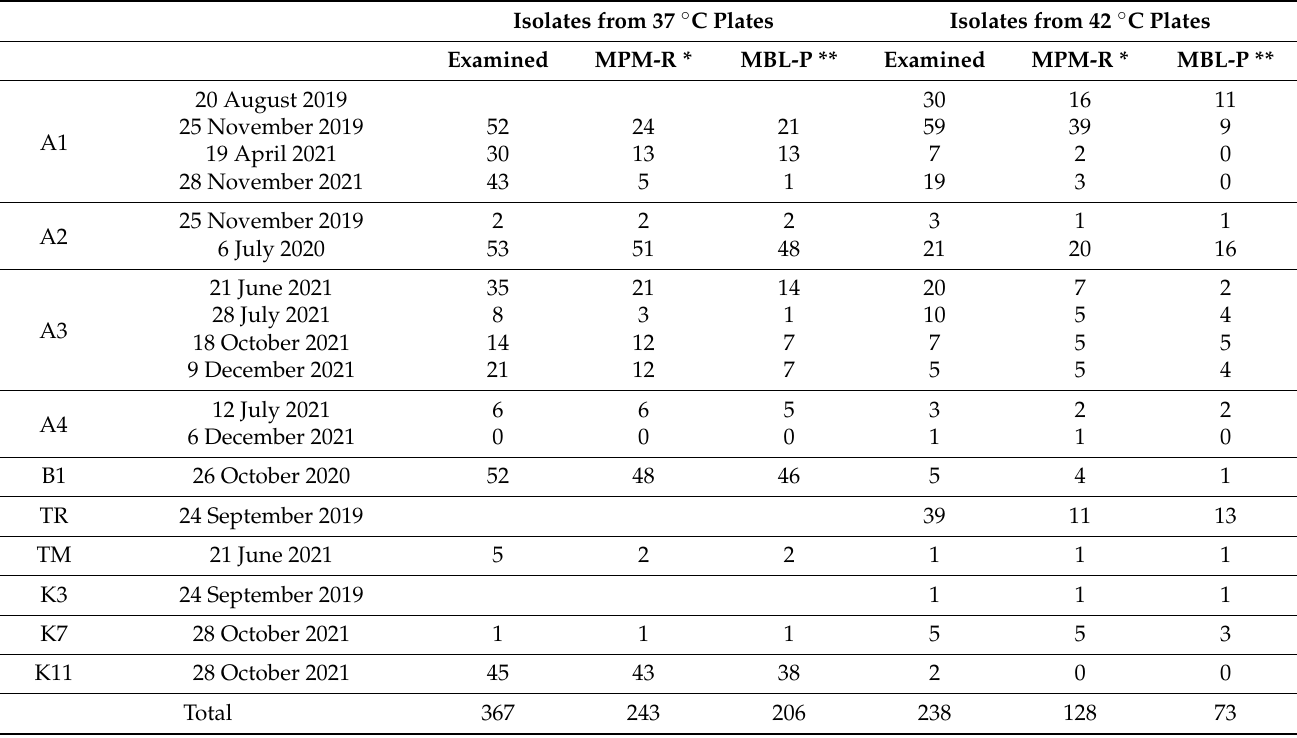
Table 1. Number of isolates examined in this study and the phenotype of the isolates.